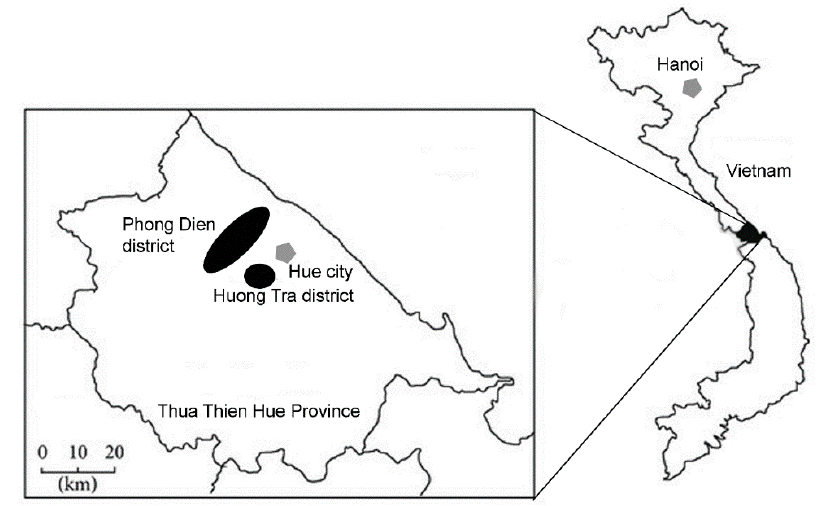
Figure 1. Thua Thien Hue province and the target area.